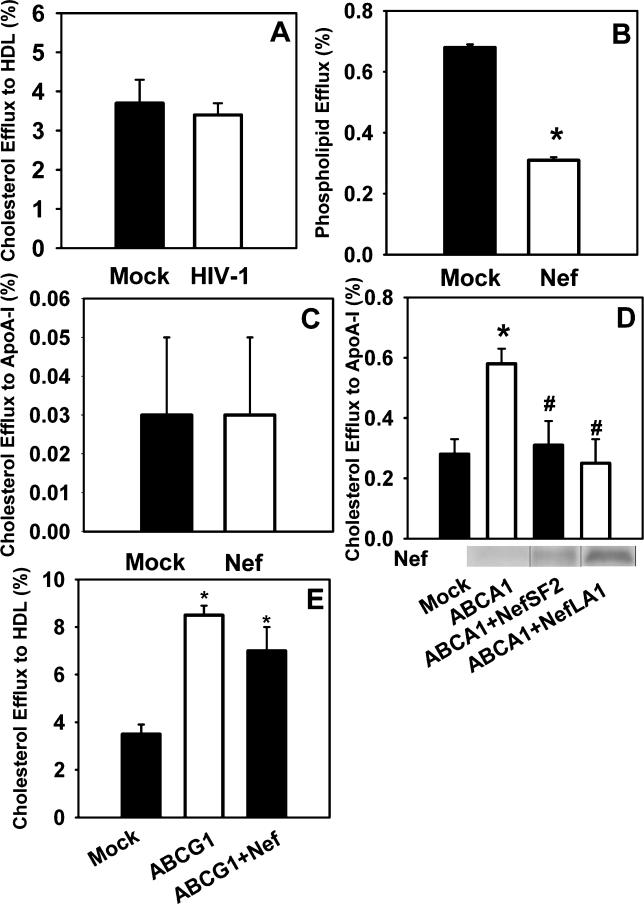
Nef Targets ABCA1-Dependent Cholesterol Efflux(A) Cholesterol efflux to HDL (30 μg/ml) was measured from HIV-1 ADA-infected and mock-infected macrophages used also to measure efflux to apoA-I in Figure 1A.(B) Impairment of phospholipid efflux in Nef-transfected RAW 264.7 cells. RAW 264.7 cells were transfected with plasmid expressing HIV-1 SF2-derived Nef or empty vector (mock-transfection). Phospholipid efflux to apoA-I (30 μg/ml) was measured as described in Methods. Means ± SD of quadruplicate determinations are shown. An asterisk (*) indicates p < 0.001.(C) Nef does not decrease cholesterol efflux in RAW 264.7 cells not treated with LXR agonist. Experiment was performed using HIV-1 SF2-derived Nef as described in Figure 1C, except that LXR agonist was not added.(D) Cholesterol efflux to apoA-I from HeLa cells. HeLa cells were either mock-transfected (mock) or co-transfected with ABCA1 and empty vector (ABCA1), or vector expressing Nef derived from HIV-1 SF2 (ABCA1 + NefSF2) or LAI strains (ABCA1 + NefLAI); cholesterol efflux to apoA-I was analyzed. An asterisk (*) indicates p < 0.001 (versus cells without ABCA1); a number sign (#) indicates p < 0.001 (versus cells without Nef). Expression of Nef determined by Western blot is shown beneath the bars.(E) Cholesterol efflux to HDL from HeLa cells. Experiment was performed as in (D), except that ABCG1 was used instead of ABCA1, and HDL (30 μg/ml) instead of apoA-I was used as cholesterol acceptor. An asterisk (*) indicates p < 0.01 (versus cells without ABCG1).